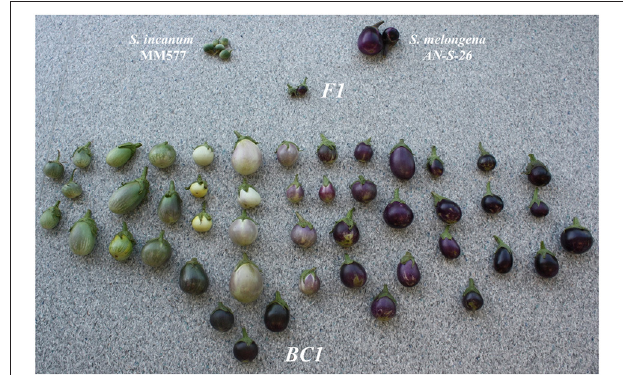
FIGURE 1 | Parents ( Solanum incanum MM577 and S. melongena AN-S-26) of the AB and IL sets, their hybrid (F1) and the segregating first backcross (BC1) generation to the recipient parent S. melongena